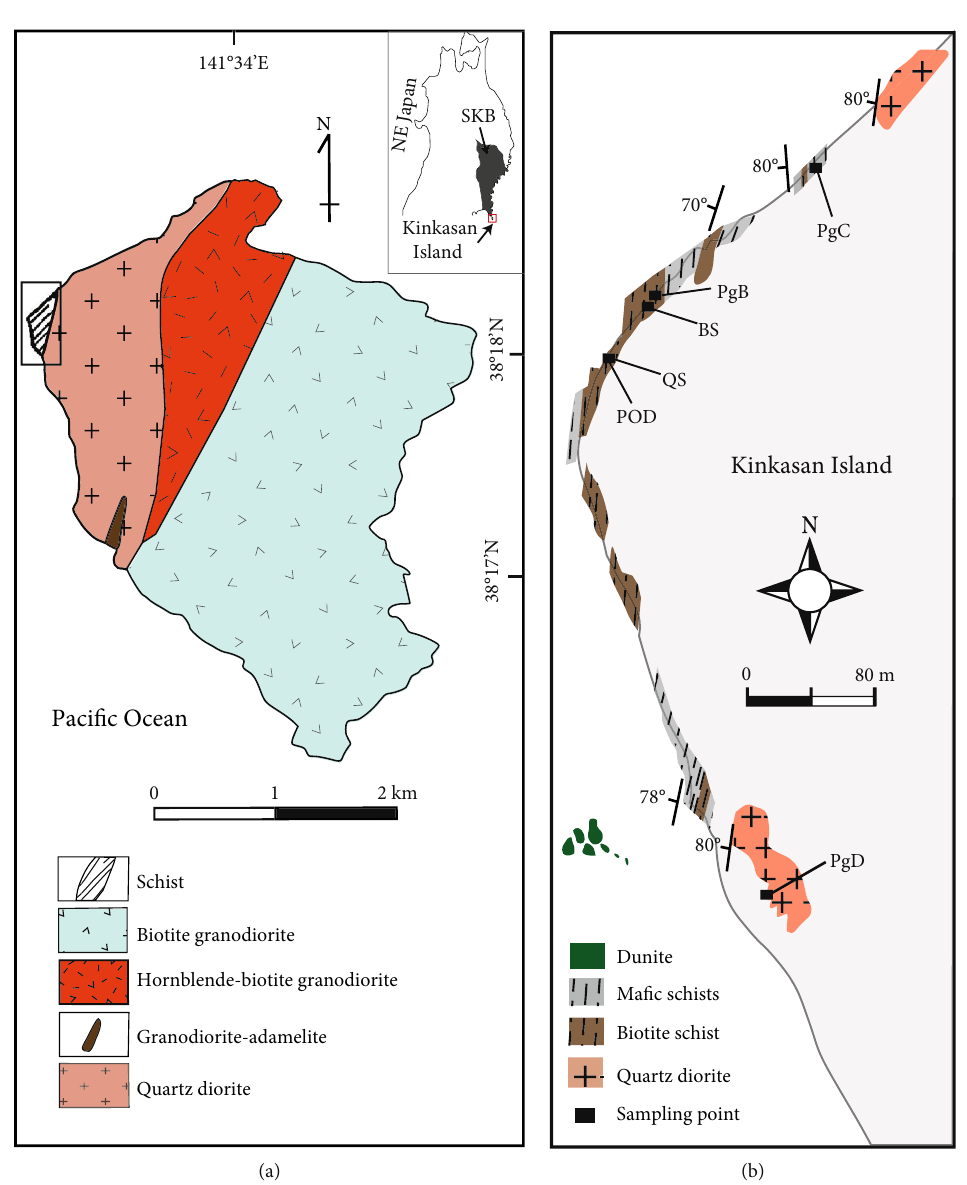
Figure 1: (a) Simpli fi ed geological map of Kinkasan Island (modi fi ed after Kobayashi [62]). The open rectangle indicates the study area. (b) Map of the metamorphic unit and quartz diorite along the northwestern coastline of Kinkasan Island (modi fi ed after Inoki et al. [23] and Nurdiana et al. [24]), showing the sampling locations. PgD: Qz diorite-hosted pegmatite; PgC: Cpx schist-hosted pegmatite; PgB: Bt schist- hosted pegmatite; BS: Bt schist; QS: Qz schist; POD: garnetite